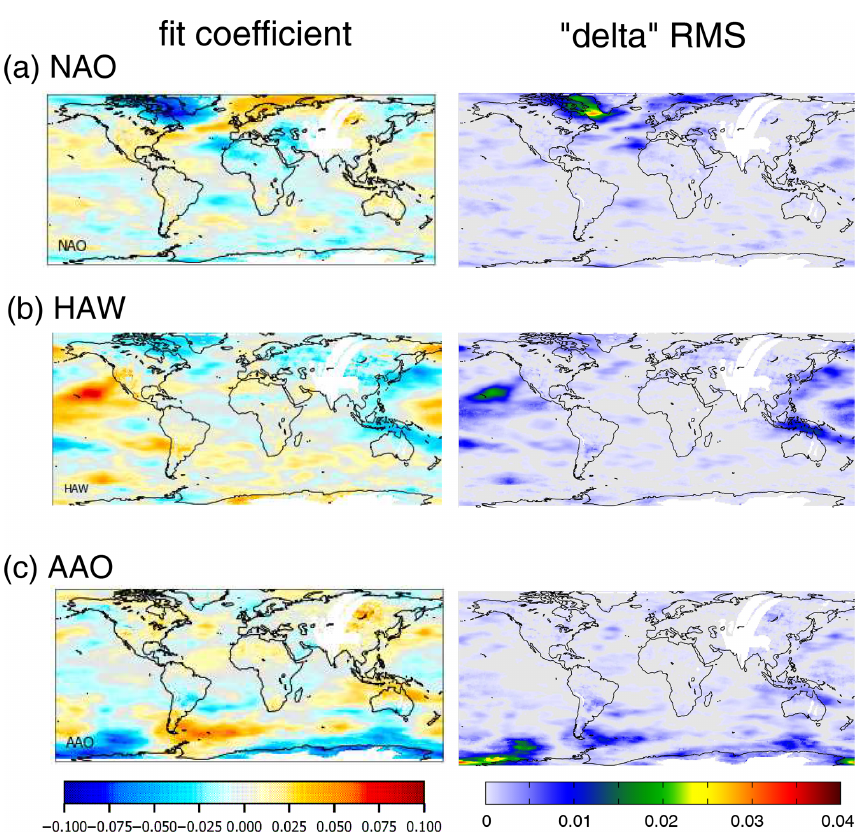
Figure 5. Global maps with the fit results (left) and delta rms (right) for selected teleconnection indices with activity centres in northern high latitudes (a) , subtropics (b) and southern high latitudes (c) . Results for the TCWV data set from satellite observations.